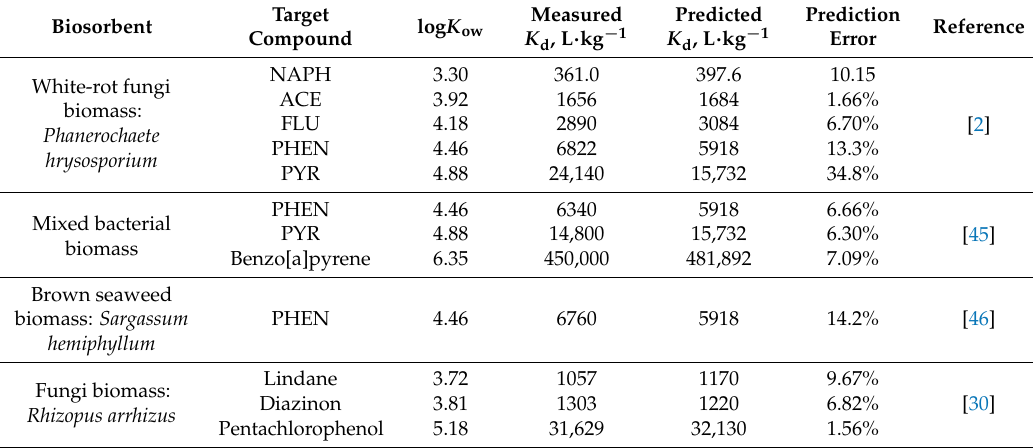
Table 4. Isothermal parameters of biosorption of PAHs onto biomass using Freundlich and linear